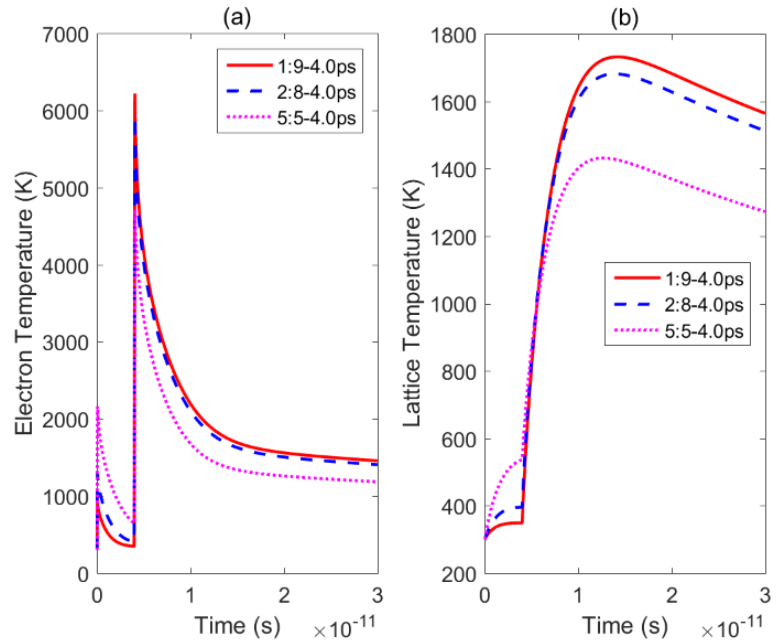
Figure 8. Changes in the lattice and electron temperatures over time under irradiation by double pulses with three energy ratios: ( a )—electron temperatures obtained by irradiation with double pulses with a delay time of 4.0 ps and energy ratios of 1:9 (solid red line), 2:8 (dotted blue line), and 5:5 (dotted pink line); ( b )—lattice temperatures obtained by irradiation with double pulses with a delay time of 4.0 ps and energy ratios of 1:9 (solid red line), 2:8 (dotted blue line), and 5:5 (dotted pink line).